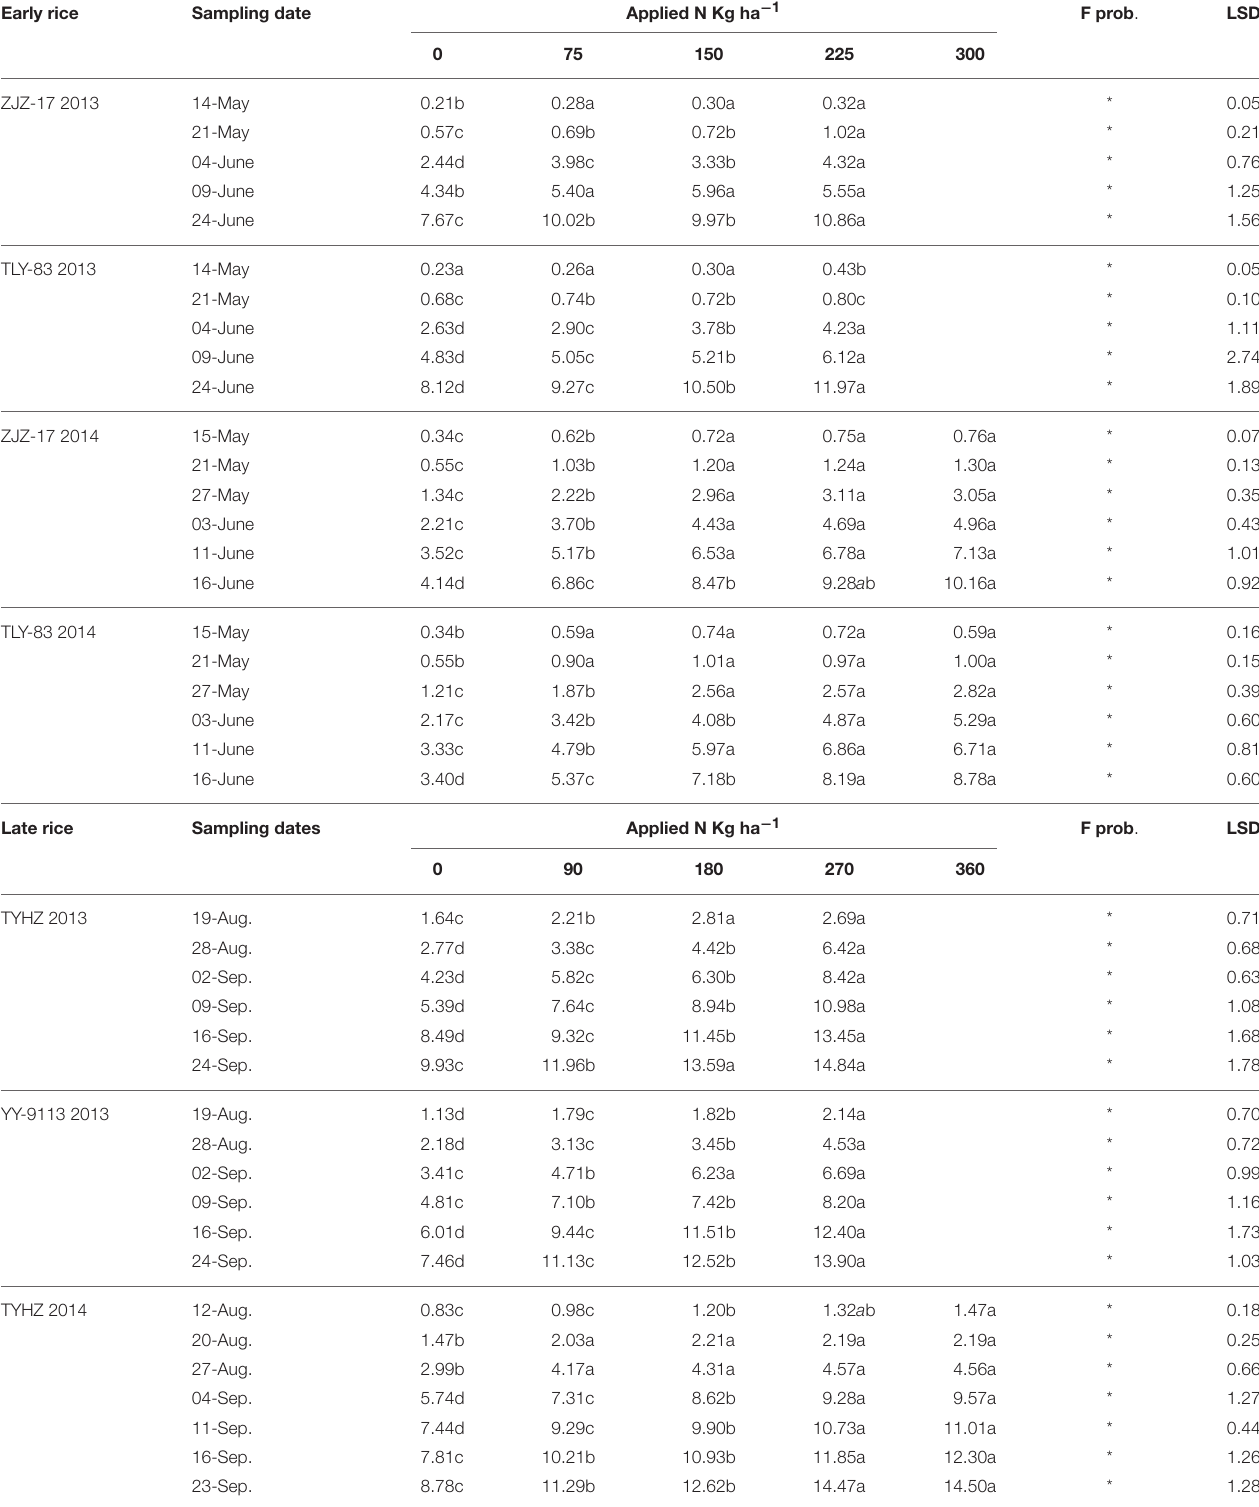
TABLE 2 | Shoot biomass on different sampling dates under different N treatments. Early